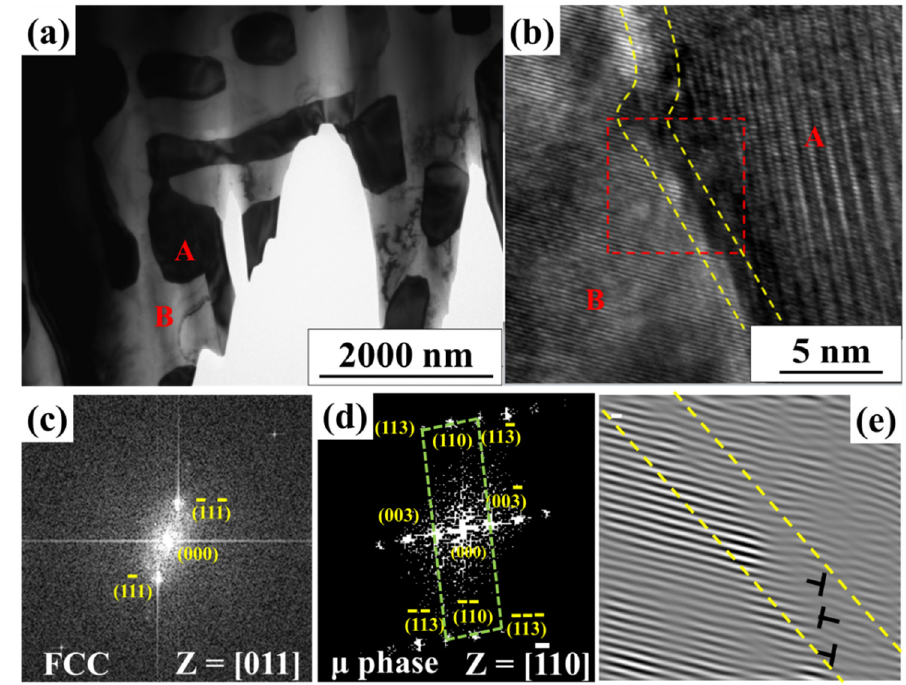
Figure 4. ( a ) Bright-field (BF) image for (CoCuFeNi) 81 Mo 19 HEA; ( b ) the high resolution transmission electron microscopy (HRTEM) image of the interface between FCC and µ phase; ( c ) the fast Fourier transformation (FFT) image of the face-center-cubic phase; ( d ) the FFT image of the µ phase and ( e ) the inverse FFT image of the interface region.